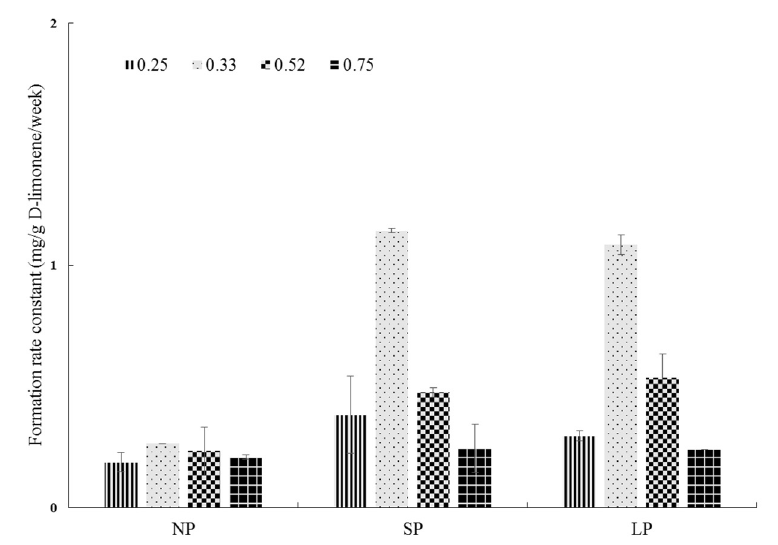
Figure 5. Formation time-courses of limonene oxide in spray-dried powders stored under various a w conditions at 37 °C. ( a ) Large-size powder, LP. ( b ) Small-size powder, SP. ( c ) Nano-size powder, NP.